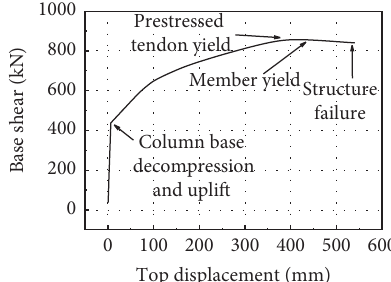
Figure 9: Pushover curve for the SC-CBF structure.